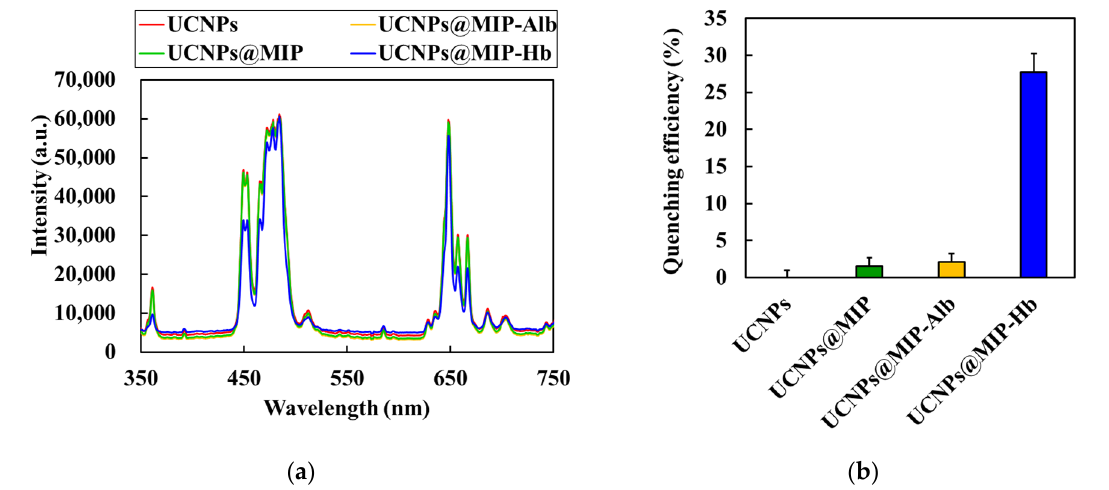
Figure 5. ( a ) Photoluminescence spectra and ( b ) efficiency of fluorescence reduction for the UCNPs, UCNPs@MIP, and UCNPs@MIP bound to albumin and hemoglobin. The quenching efficiency is expressed as (F o − F)/F o , where F o and F are the fluorescence intensities at 450 nm.